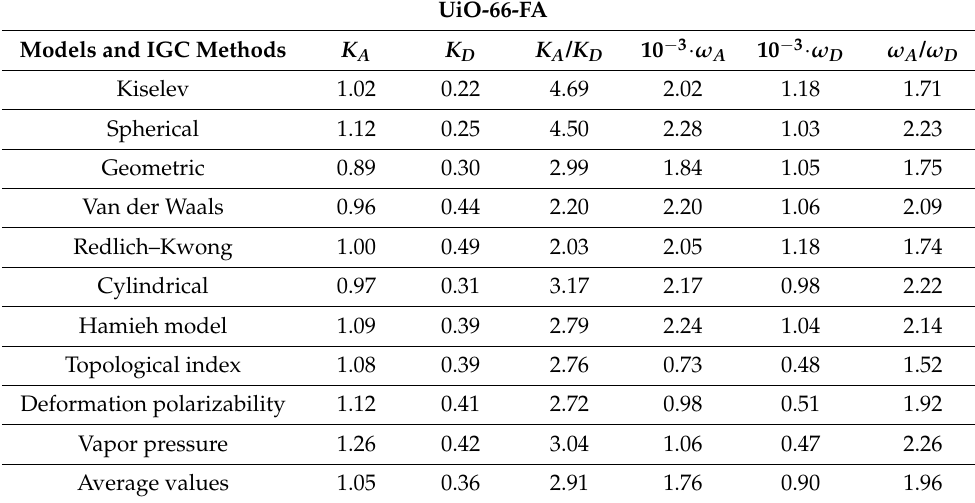
Table 8. Values of the enthalpic acid–base constants K A and K D (unitless) and the entropic acid–base constants ω A and ω D (unitless) of UIO-66-FA catalyst and their acid–base ratios for the different used molecular models and IGC methods.